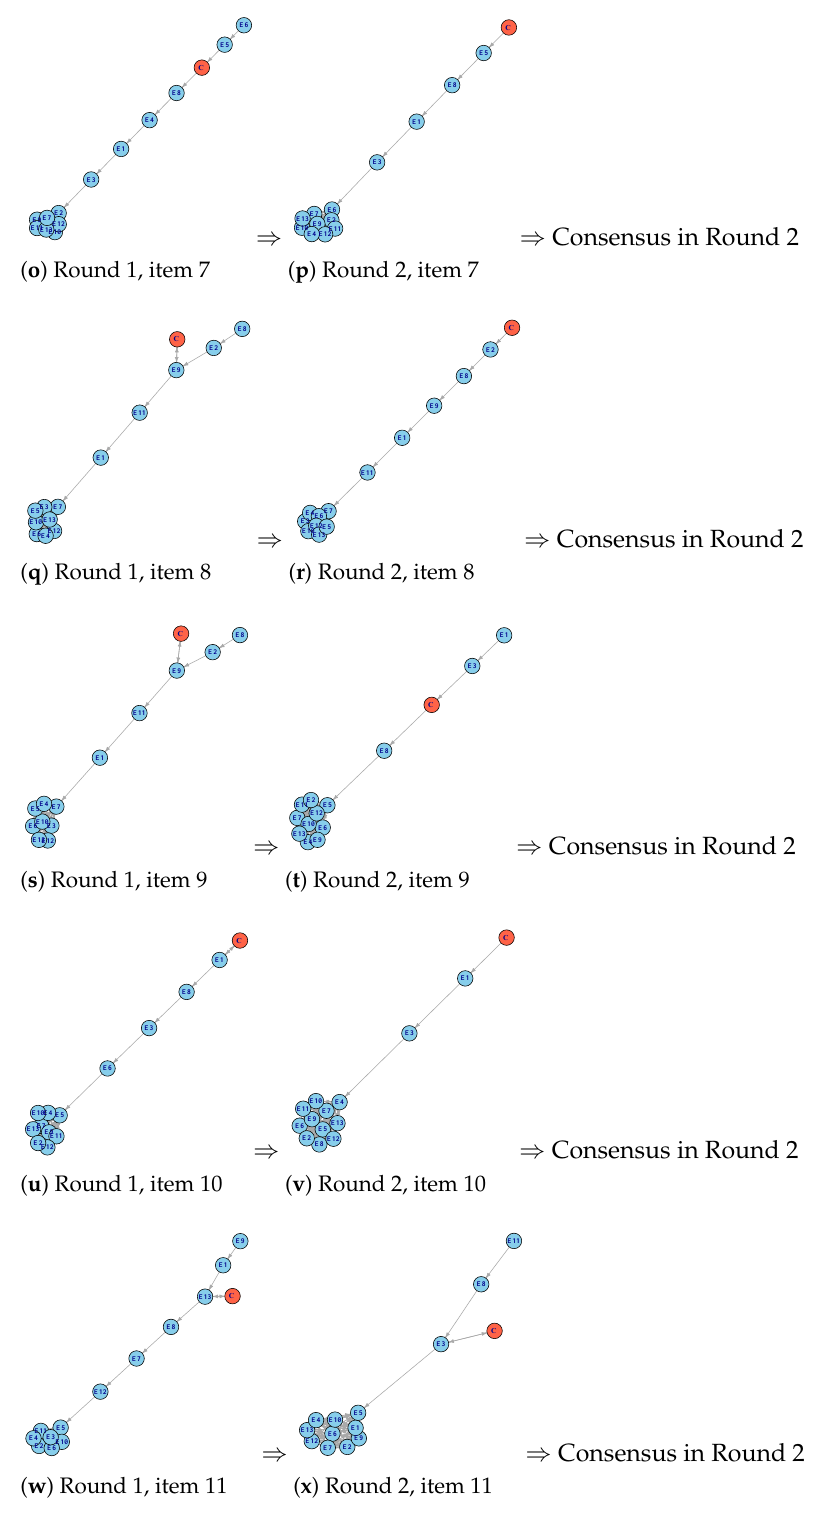
Figure 7. Fuzzy data corresponding to the 13 experts’ opinions ranked for each round and each item in blue and the comparison FN, C , in